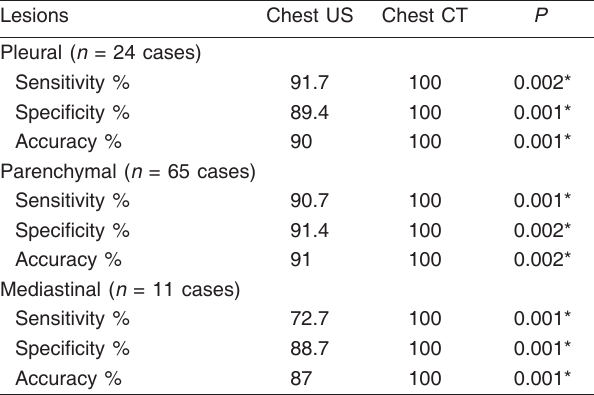
Table 1 Statistical comparison between chest ultrasonography and computed tomography regarding their specificity, sensitivity, and accuracy in detecting pleural, pulmonary, and mediastinal lesions (100 cases)